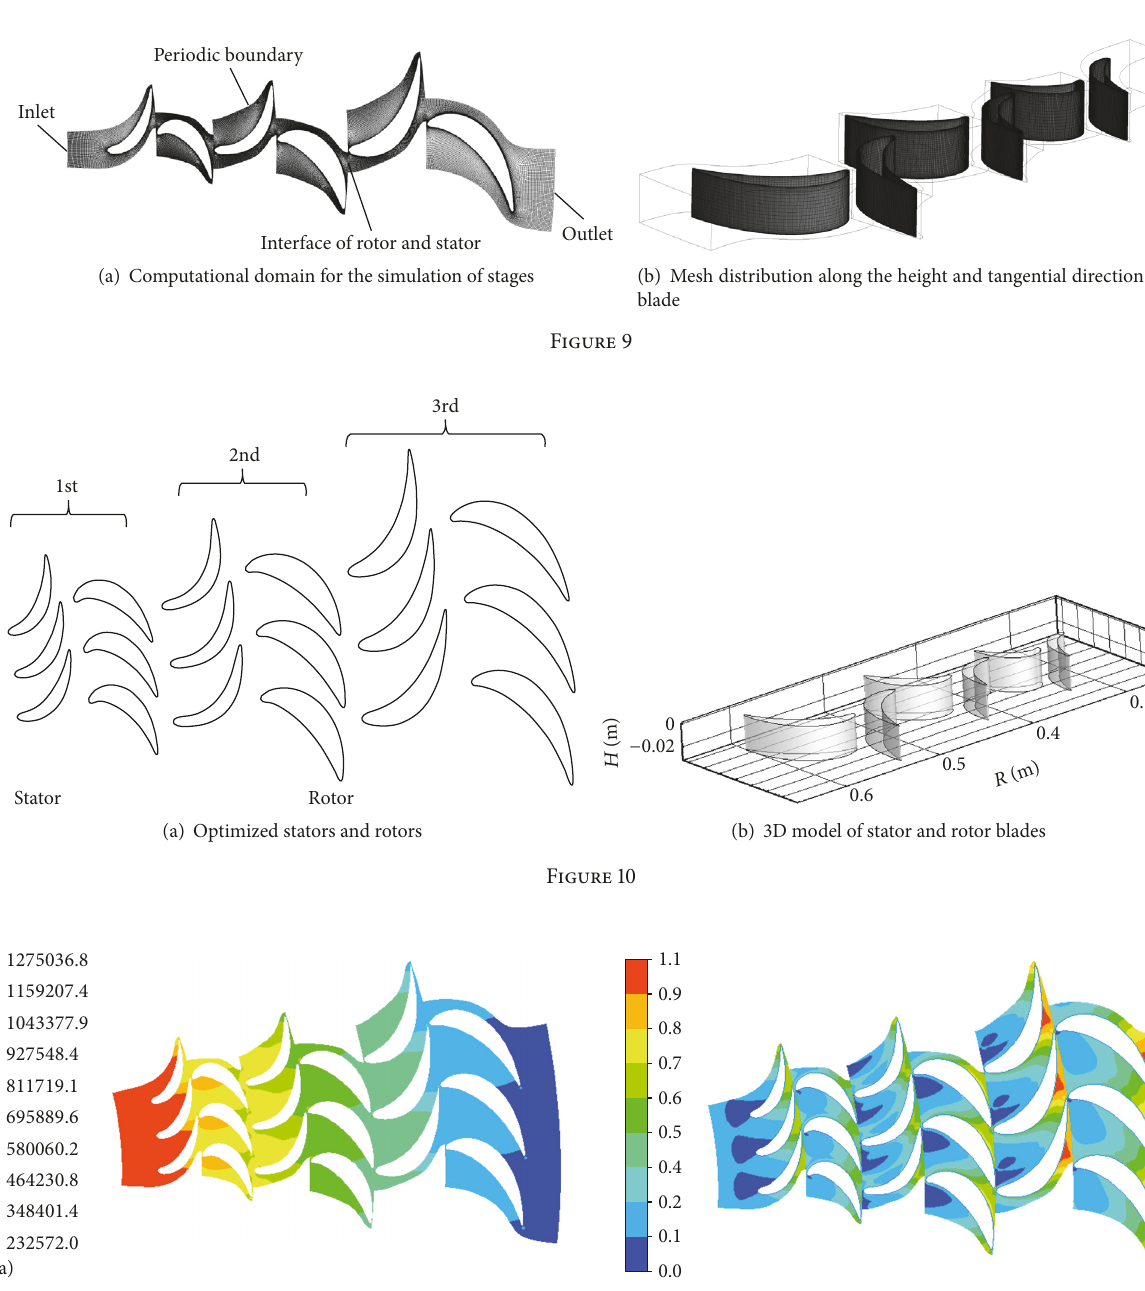
Figure 11: Static pressure distribution. Figure 12: Mach number